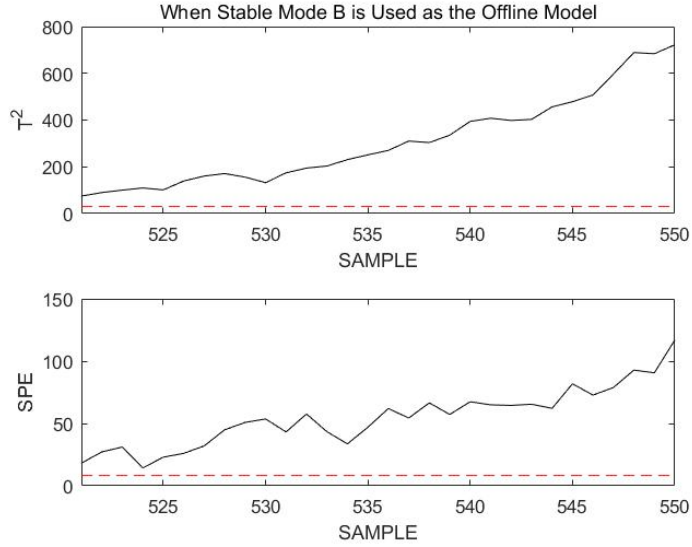
Figure 8. Monitoring 521st to 550th sample points using stable mode B as an offline model.